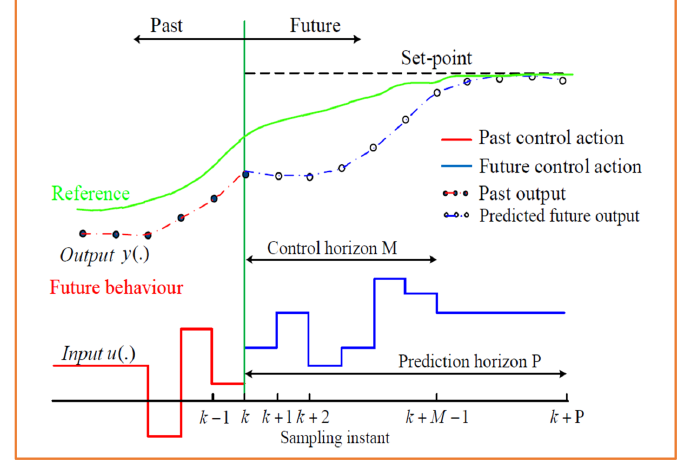
Figure 5. MPC control strategy [37].